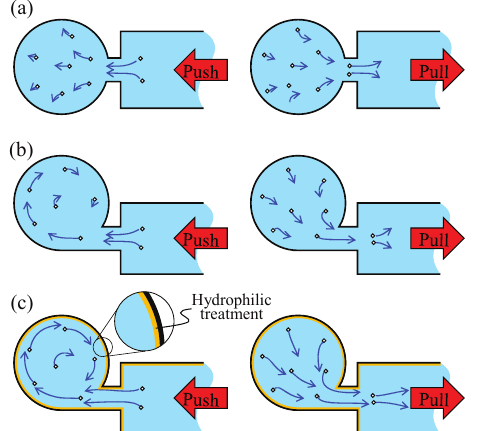
Figure 1. Different scales of swirling motion are introduced under different conditions of push/pull motion: flow patterns ( a ) for a symmetric design, ( b ) an asymmetric design, and ( c ) an asymmetric design with hydrophilic